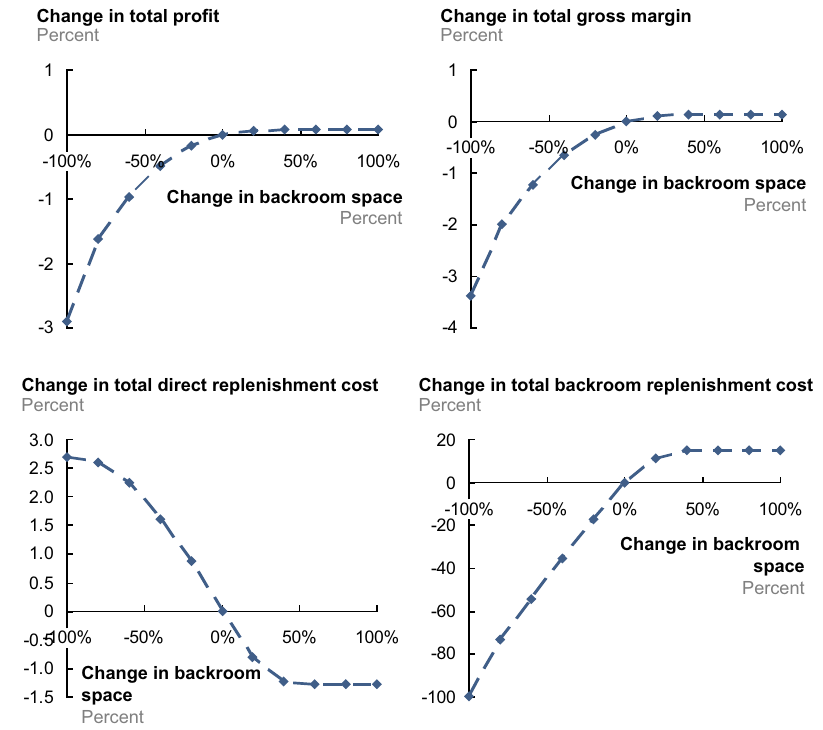
Fig. 6 Impact of backroom availability on financial